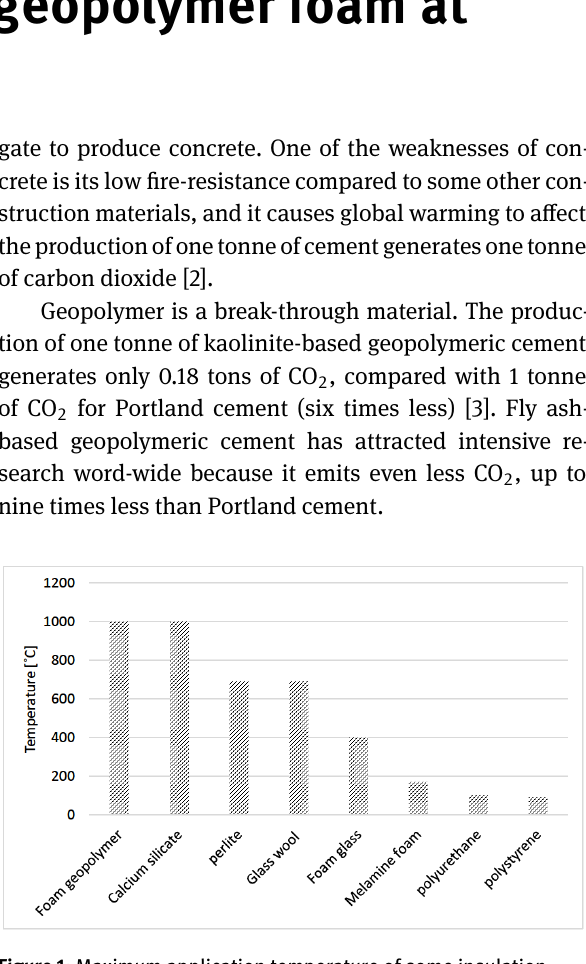
Figure 1: Maximum application temperature of some insulation materials